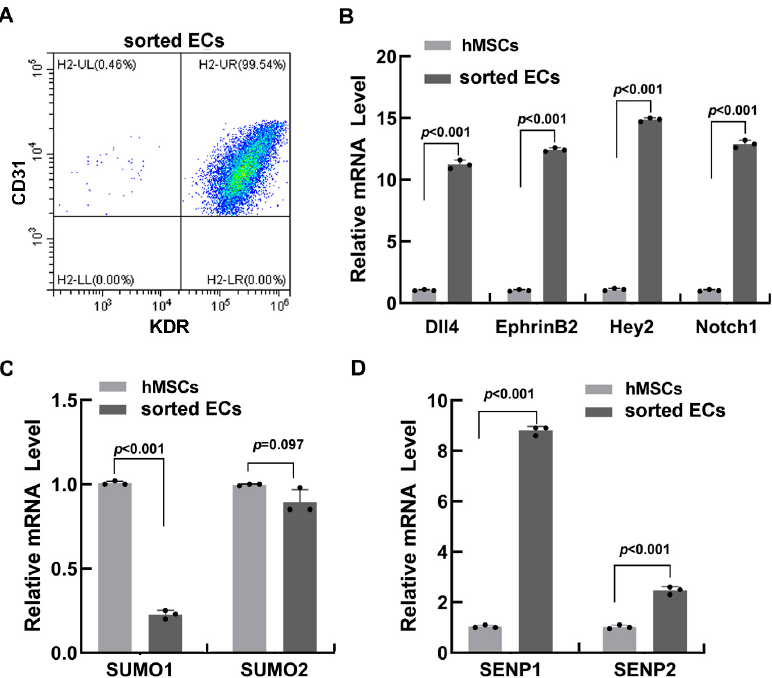
Figure 1. SENP1 participates in arterial-specific endothelial differentiation of hMSCs. ( A ) MSC-differentiated EC cells (CD31- and KDR-positive) were sorted at 7 days and cultured in EDM media with a purity of 99.54%. ( B ) Arterial-specific marker genes ( Dll4 , EphrinB2 , Hey2 , and Notch1 ) were examined in obtained ECs by qRT-PCR. ( C , D ) The expression changes of SUMO1-2 and SENP1-2 during endothelial differentiation were determined by qRT-PCR. Bar graphs are shown as the mean ± SD with individual points from three independent experiments ( p values were indicated in the graph, individual data points were shown as scattered black dots).